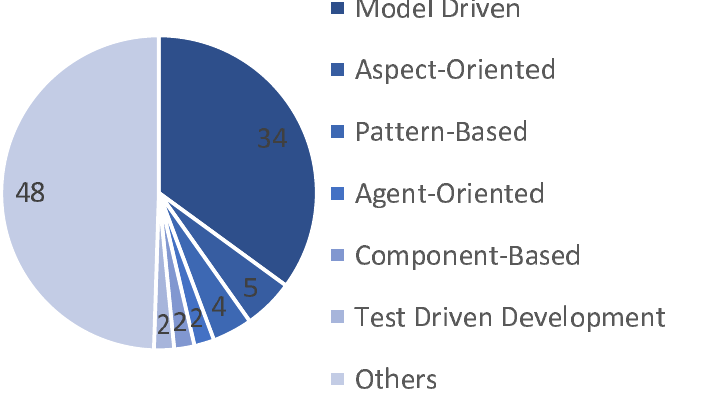
Figure 7. Papers referencing the intended development methodology (adopted from [247] with updates of numbers).